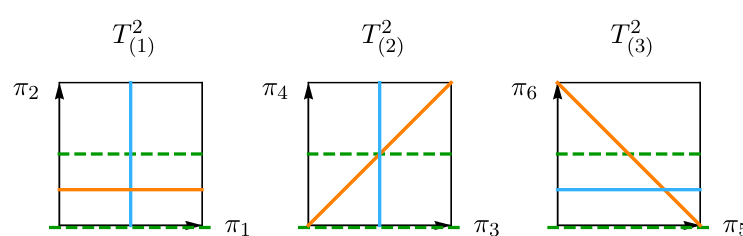
Figure 3 . D6-brane con(cid:12)gurations with codimension 6 intersection preserve a local N = 1 super- symmetry. The O6-planes are represented by the dashed, green